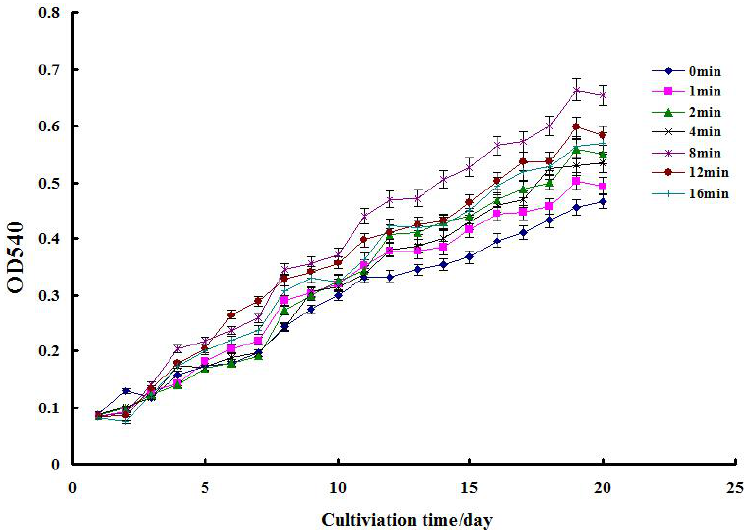
Figure 4. Microalgal cell growth curves after irradiated by semiconductor Laser with different time.